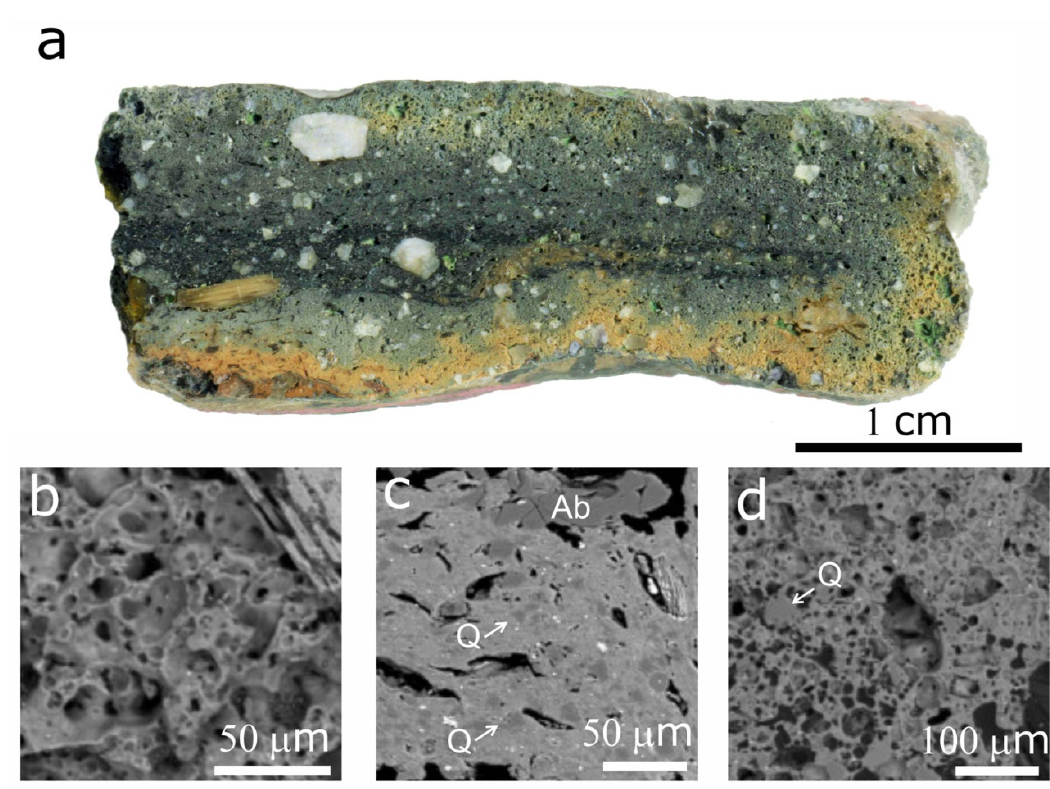
Figure 3. Microscopic image of the crucible cross-cut section ( a ) and BSE images of the clay matrix from the inner edge ( b ), central zone ( c ), and outer edge ( d ) of the crucible. Ab—albite; Q—quartz.